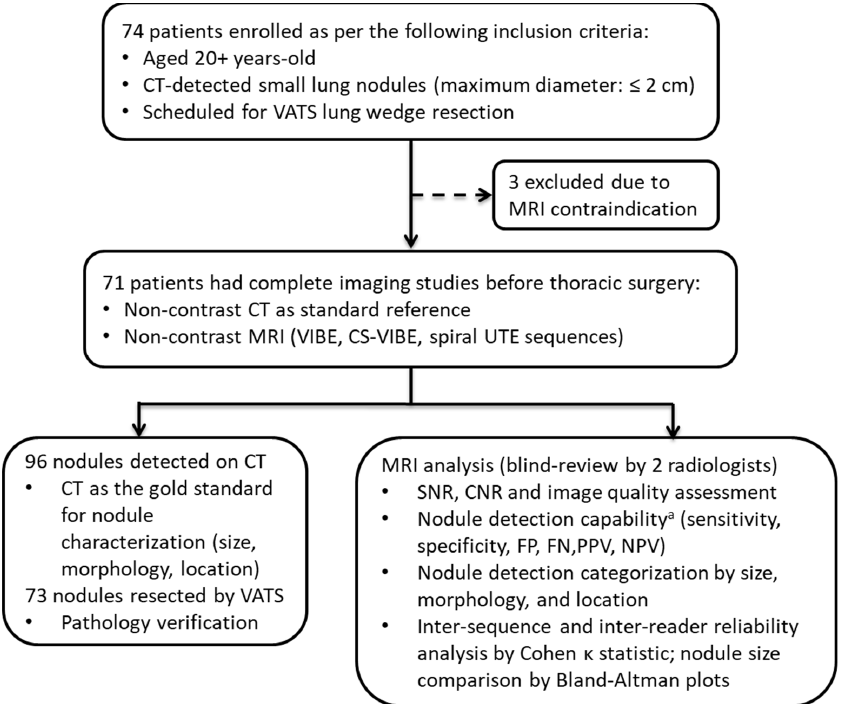
Figure 1. Flowchart of the study. a Radiologists recorded the presence or absence of nodules on a lobe-by-lobe basis. Abbreviations: CT: computed tomography; VATS: video-assisted thoracoscopic surgery; MRI: magnetic resonance imaging; CS: compressed sensing; VIBE: volumetric interpolated breath-hold examination; UTE: ultrashort echo time; SNR: signal-to-noise ratio; CNR: contrast-to- noise ratio; FP: false positive; FN: false negative; PPV: positive predictive value; NPV: negative predictive value.